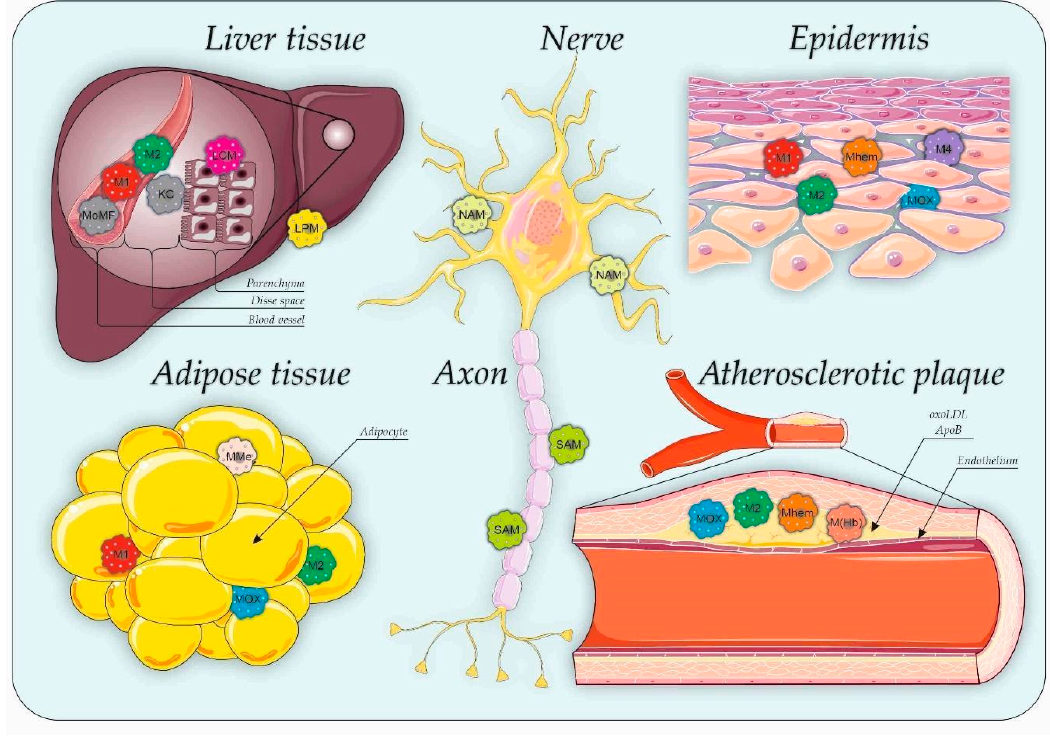
Figure 1. Tissue distribution of macrophages in non-infectious metabolic disorders. M1—